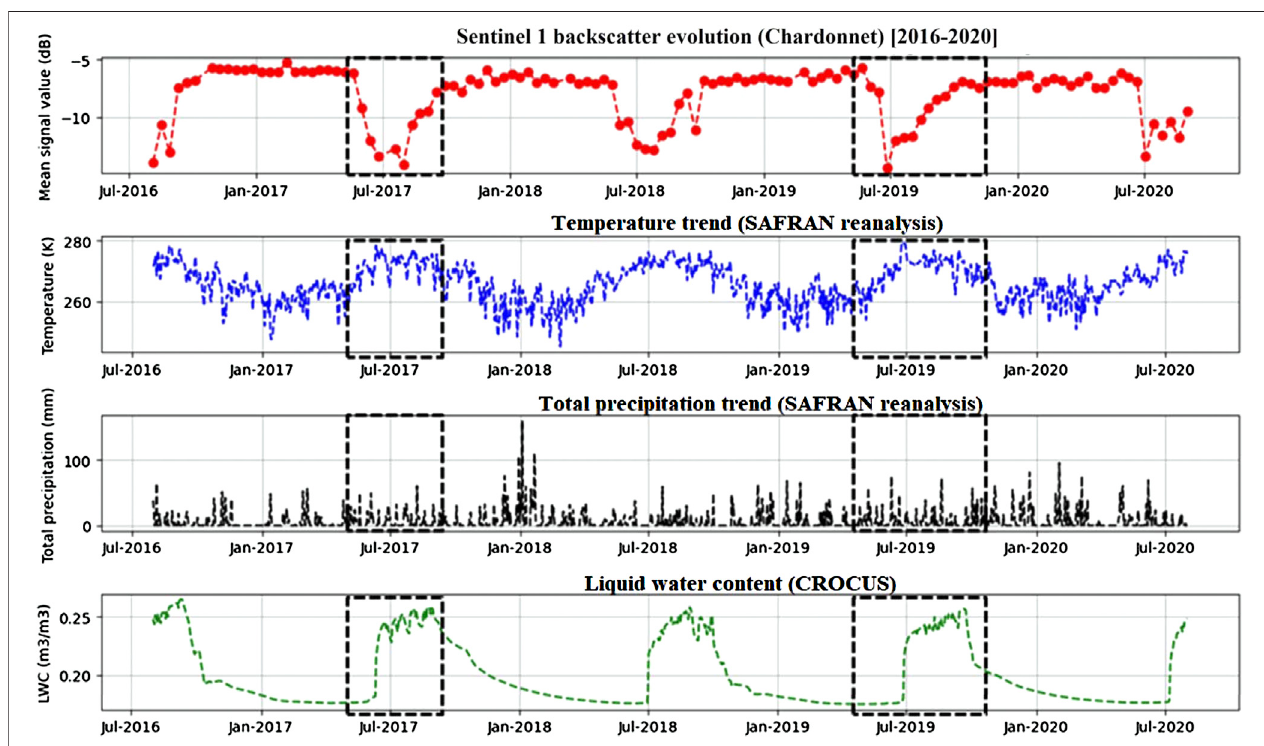
FIGURE 8 | Joint analysis of the temporal backscattering pro fi le for the IA on the north face of Chardonnet with meteorological parameters (air temperature, precipitation, and liquid water content).